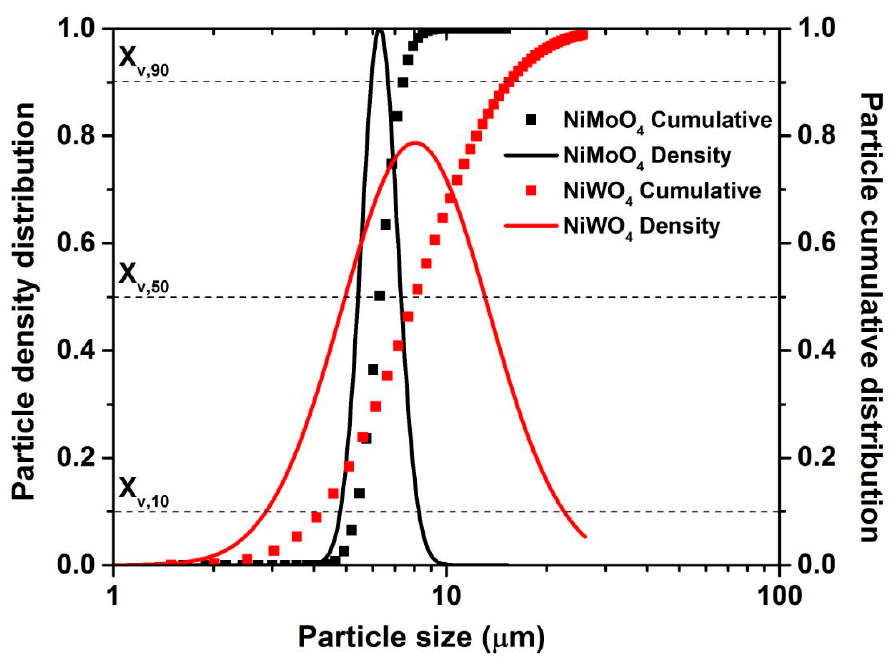
Figure 8. Cumulative (symbols) and density (solid lines) hydrodynamic particle size distribution obtained for NiMoO 4 and NiWO 4 after dispersion in N-methyl-2-pyrrolidone (NMP).